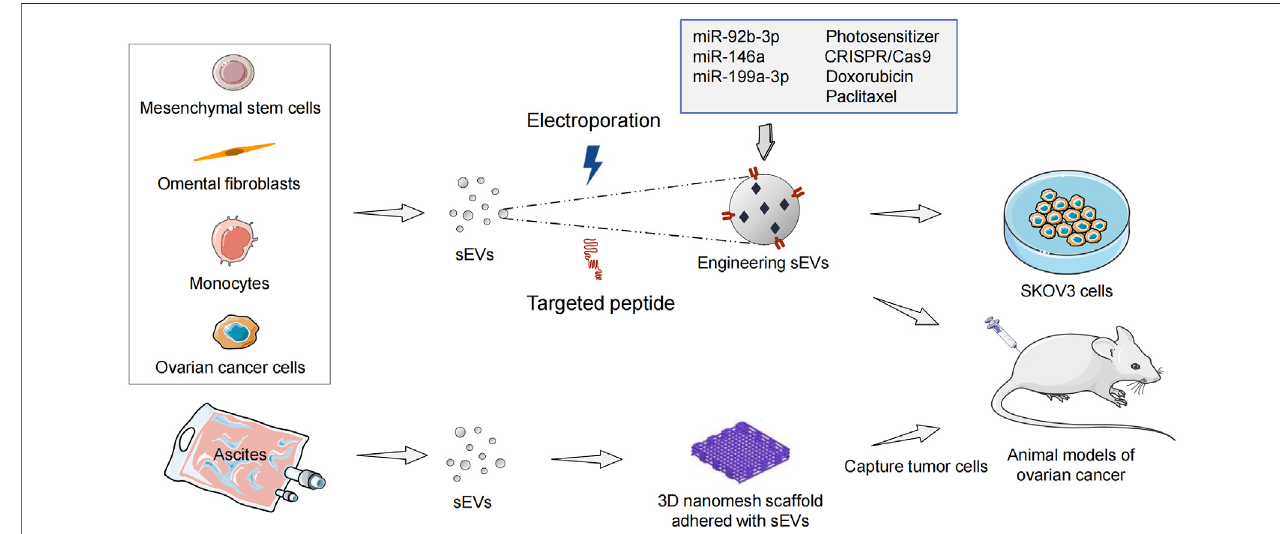
FIGURE 3 | Engineering sEVs targeted delivery of ncRNAs and anticancer drugs in ovarian cancer treatment. sEVs, small extracellular vesicles; ncRNA, non- coding RNA.